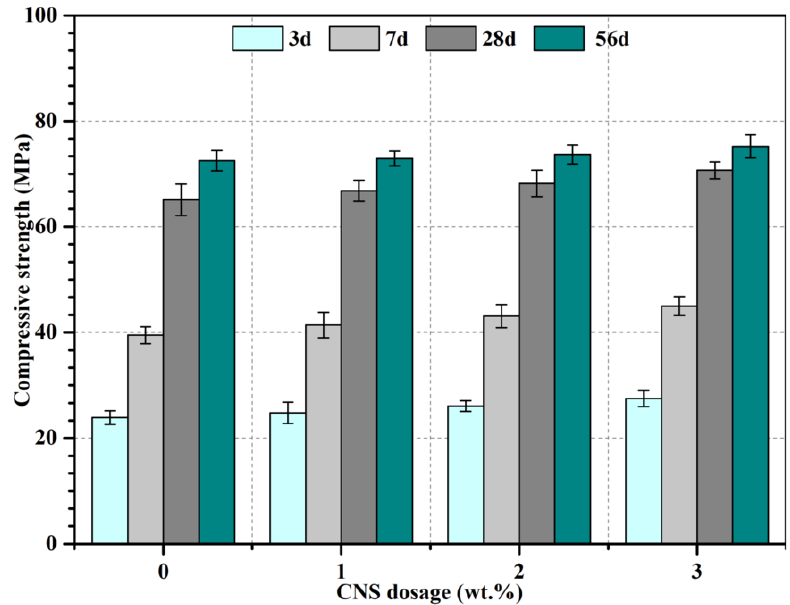
Figure 10. Compressive strength of cement mortars containing CNS.